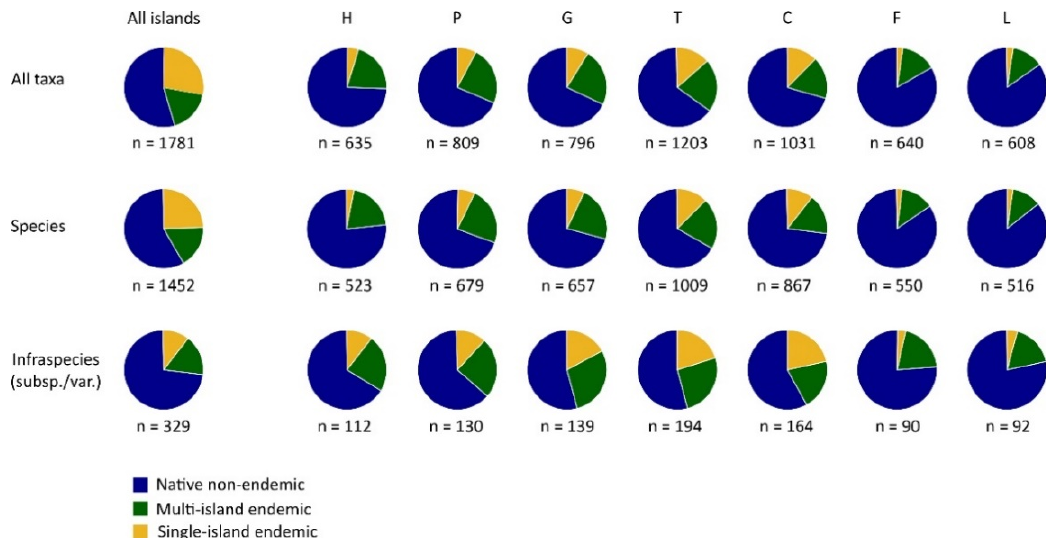
Figure 3. Categories for native taxa subdivided into native non-endemic species (blue), multi-island endemics (green) and single island endemics (yellow). Proportions are given at the level of all taxa, and separately for species and infraspecific taxa (sub-species and varieties). Absolute numbers of taxa are given below the pie charts (n). The relations are illustrated for the entire Canary Islands archipelago (All islands) and for the individual islands El Hierro (H), La Palma (P), La Gomera (G), Tenerife (T), Gran Canaria (C), Fuerteventura (F) and Lanzarote (L). Surprisingly, approximately one quarter of all species in the entire archipelago are SIE. The highest proportions of endemic taxa relate to the islands with pronounced topography and diverse climatic conditions (H, P, G, T,